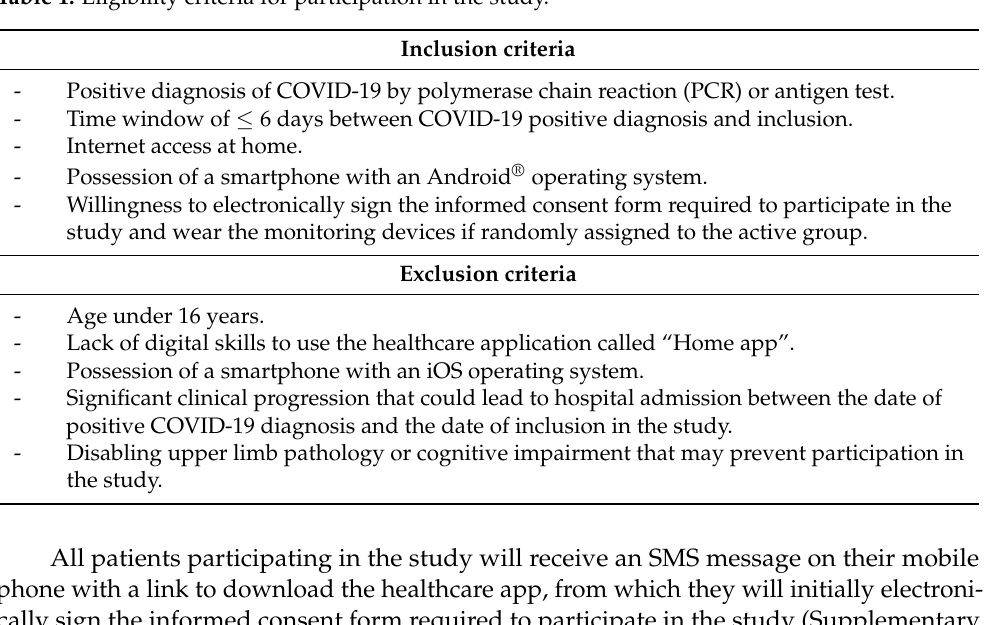
Table 1. Eligibility criteria for participation in the study.